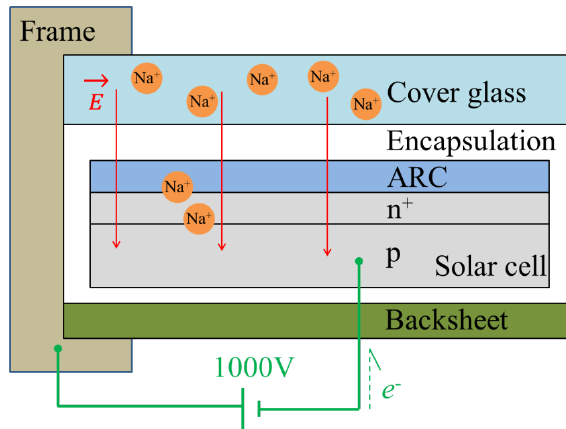
Figure 1. The structure of a crystalline Si PV module was introduced. In this diagram, the solar cells are negative-biased and the shunting model via sodium ions (Na + ) is depicted.